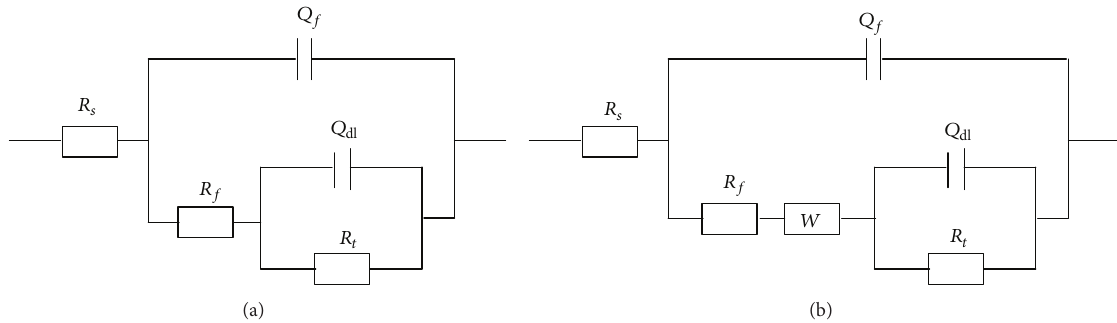
Figure 12: Equivalent circuits for 2A12 aluminum alloy with different exposure time in 0.1 M NaCl: (a) Model A and (b) Model B.